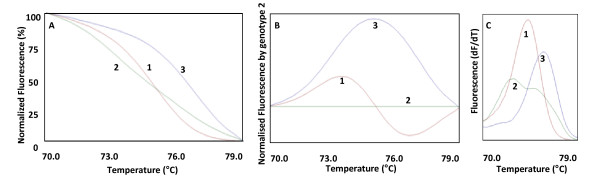
Graphs of the SLCO1B1 rs4149056 (c.T521C, exon 5) nucleotide changes results in different curve patterns using high resolution melting analysis. A: Graph of normalized fluorescence by temperature. B: Graph of normalized fluorescence (based on genotype 2) by temperature. C: Graph of melting curve analysis (fluorescence differential/temperature differential). 1: wild-type genotype (TT); 2: heterozygous genotype (TC); 3: homozygous genotype (CC) for the SLCO1B1 rs4149056 polymorphism. The curve patterns for the SLCO1B1 rs4363657 polymorphism (g.T89595C, intron 11) were similar to curve patterns of rs4149056.